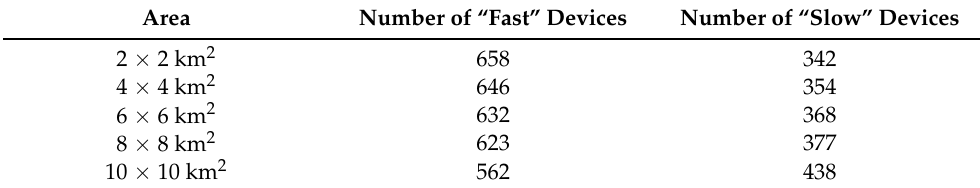
Table 4. Number of devices transmitting in each